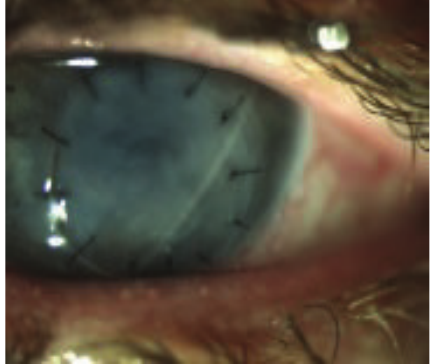
Figure 2: Postoperative appearance following corneal graft surgery with early onset corneal oedema.